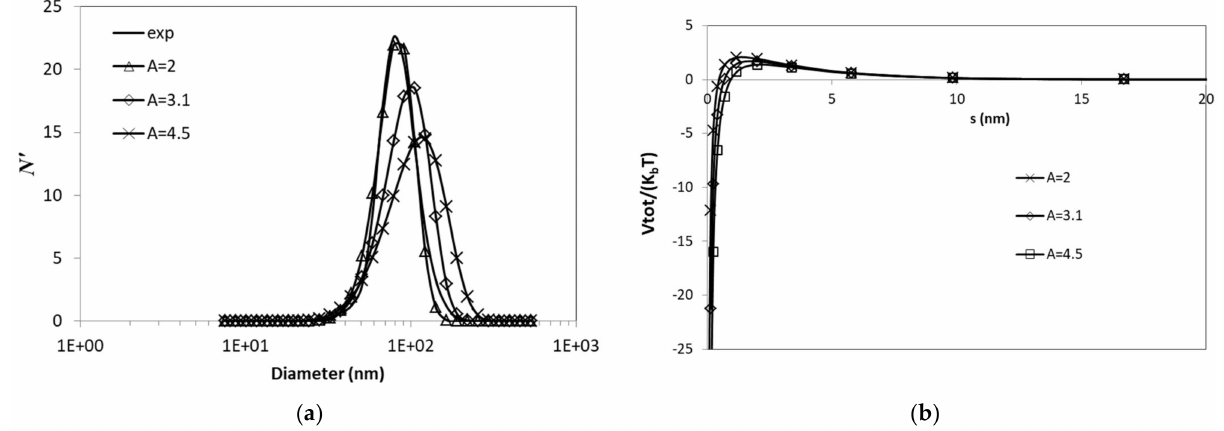
Figure 8. Effects of Hamaker constant for NaCl (10 mM) on ( a ) particle size distribution; ( b ) total potential energy (values of A are in 10 − 20